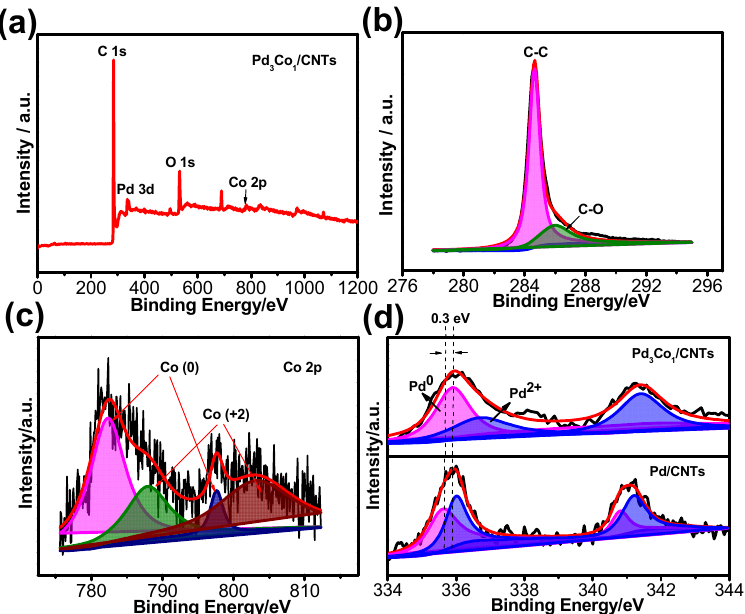
Figure 3. ( a ) XPS survey spectra, ( b ) C (1s) spectrum, ( c ) Co (2p) spectrum of Pd 3 Co 1 /CNTs, ( d ) Pd (3d) spectrum of Pd3Co1/CNTs and